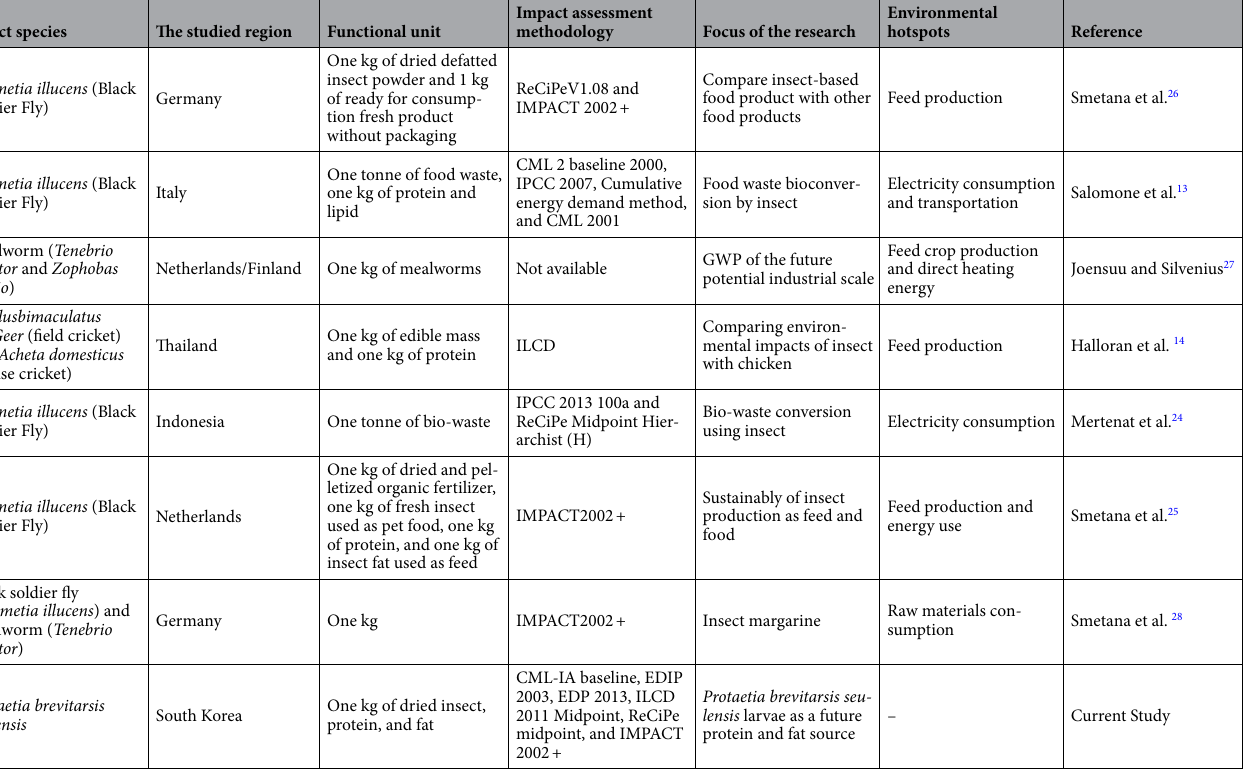
Table 1. Exemplary studies on LCA of edible insect-based